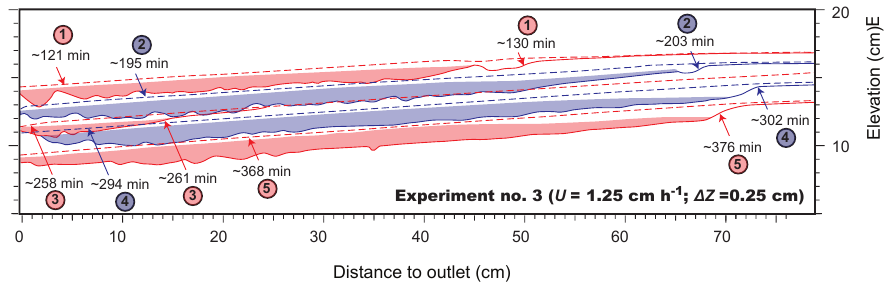
Figure 5. Evolution of the entire experiment 3 ( U = 1.25cmh − 1 ; (cid:49)Z = 0.25cm) showing alluvium thickness deposited in response to the retreat of knickpoints (enumerated from 1 to 5). Blue and red colored lines correspond to the elevation of the bedrock surface at the end of the knickpoint retreat, while the blue and red colored dashed lines correspond to the elevation of the bedrock before knickpoint propagation. Light-blue and red areas represent the alluvium. A new knickpoint is generated only when the alluvium is removed from the profile. Note the abortion of knickpoint 3 after 3min of retreat (see text for explanations). Vertical exaggeration is